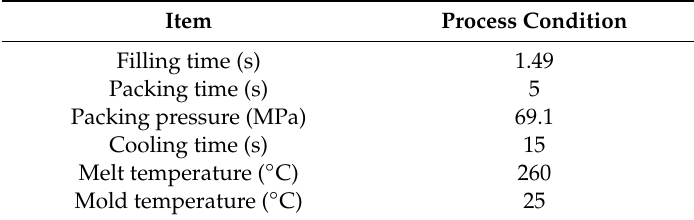
Figure 4. The observation locations at different specimen for FOD analysis. Table 1. Process condition setting for injection molding simulation.